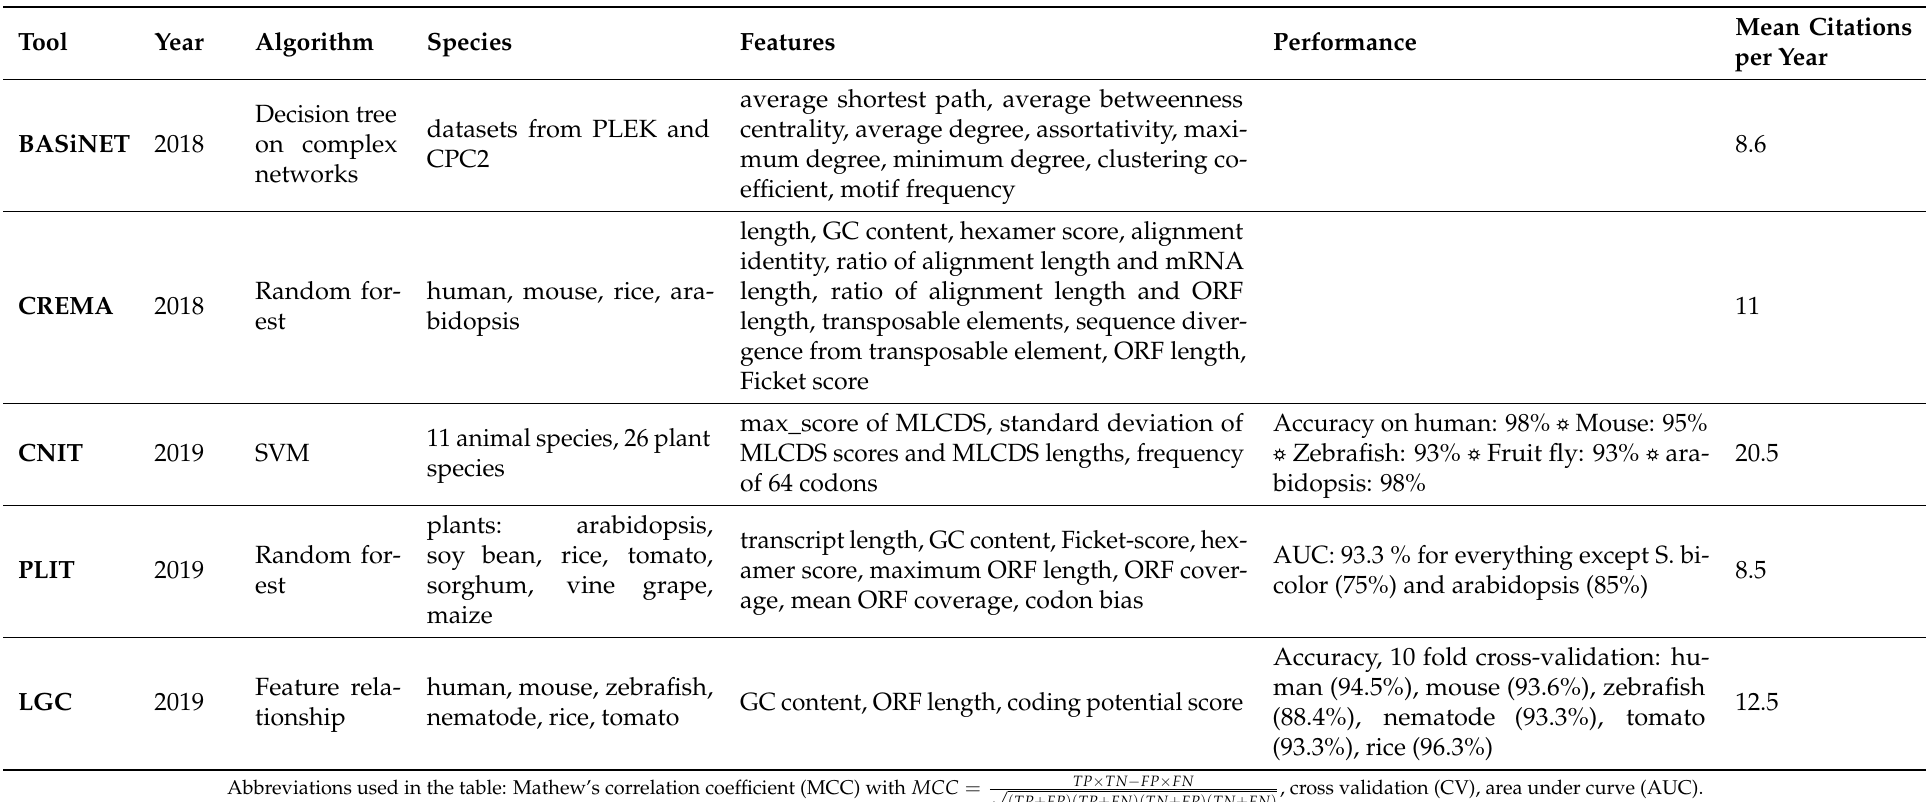
Abbreviations used in the table: Mathew’s correlation coefficient (MCC) with MCC